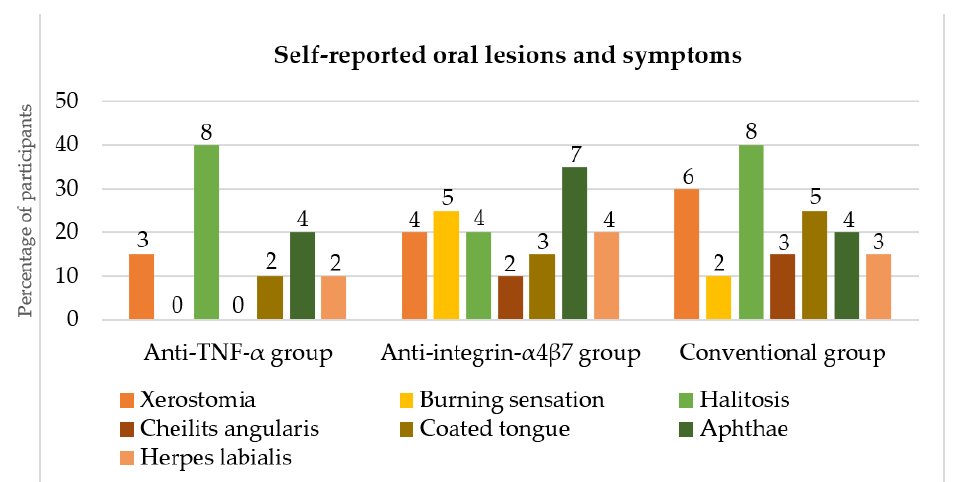
Figure 2. Self-reported oral lesions and symptoms in the anti-TNF- α , anti-integrin- α 4 β 7 and conven- tional groups (numbers above columns represent numbers of participants). TNF: tumor necrosis factor.